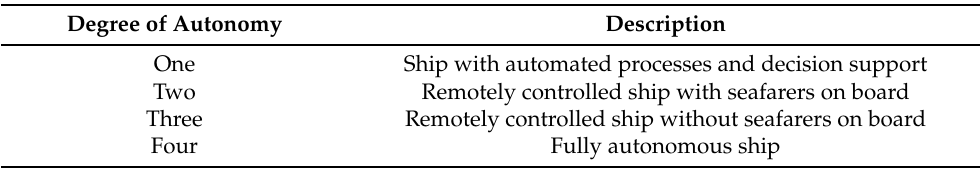
Table 3. Degrees of ship autonomy according to